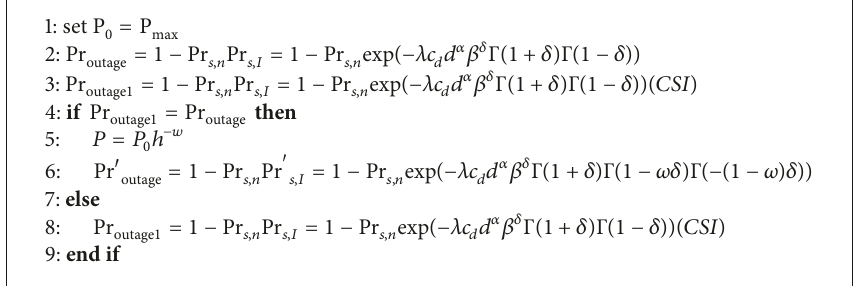
Algorithm 1: The flow diagram of power control algorithm based on outage probability